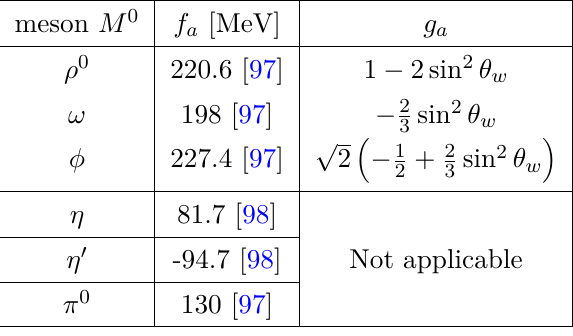
Table 4 . Decay constants and g a of neutral